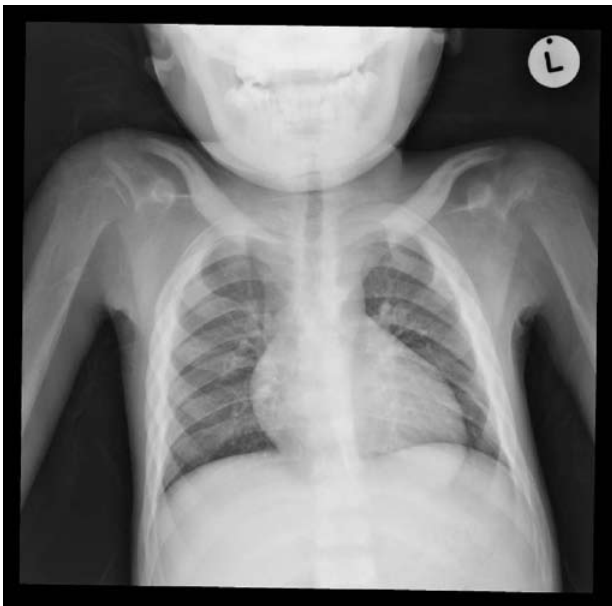
Figs 2 a - f. The diaphyses of the long bones demonstrate endosteal and periosteal thickening with narrowing of the medullary cavity. Note the typical sparring of the